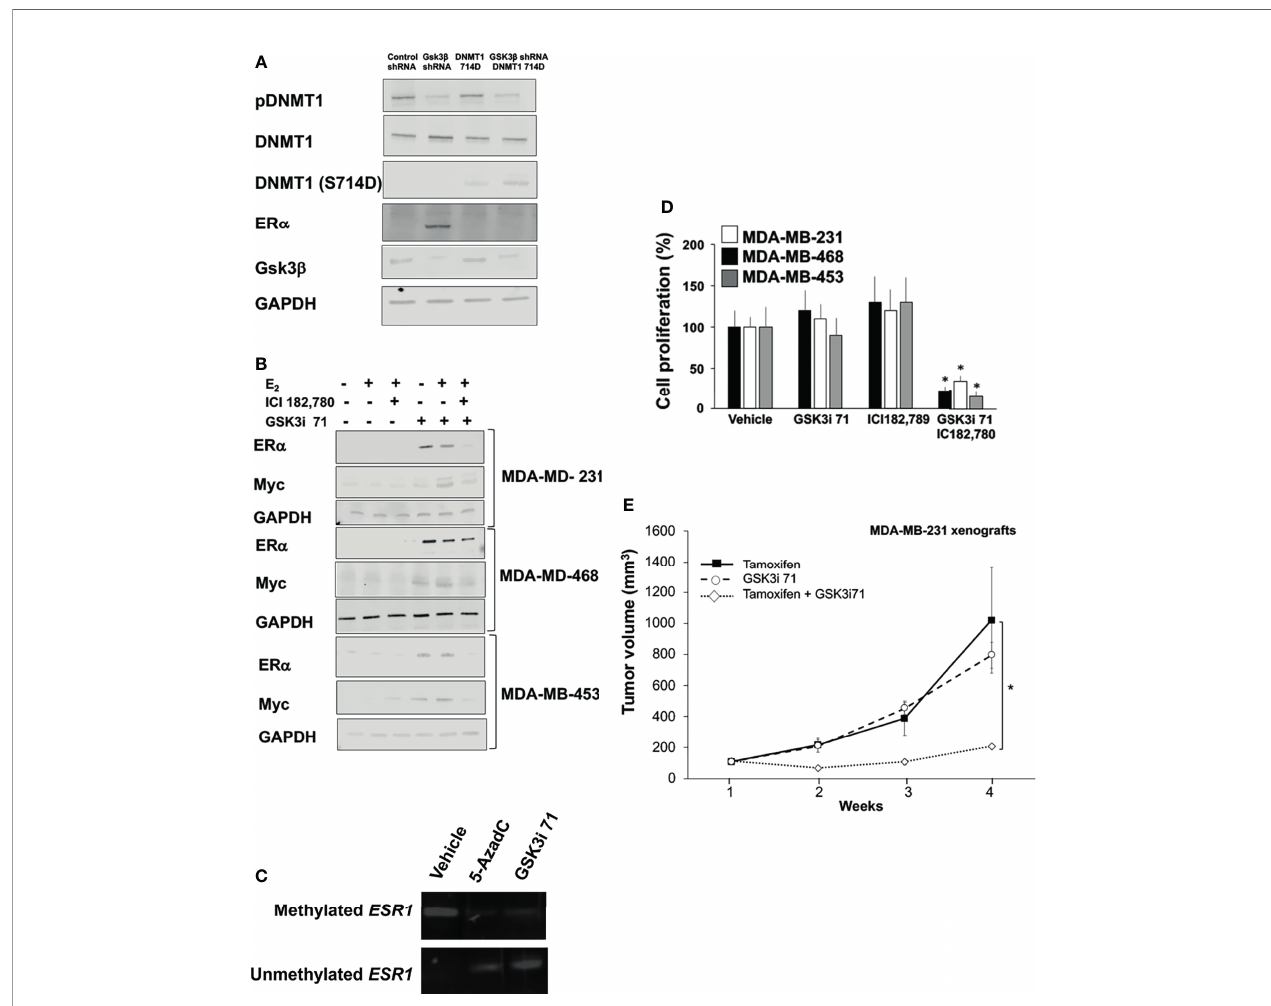
FIGURE 6 | GSK3 inhibition resulted in re-expression of ER and hormone dependence of TNBC lines. (A) MDA-MB-231 cells were transfected with expression vector for DNMT1 (S714D) and/or GSK3 b shRNA and processed for western blot analyses of indicated proteins normalized to GADPH. Figures are representative of at least 3 independent experiments. (B) TNBC lines were treated with 17 b -Estradiol (E 2 , 10 nM, 8 h), ICI182,780 (1 µM, 8 h), and/or GSK3i 71 (500 nM, 72 h). Cell were processed for western blot analyses of indicated proteins normalized to GAPDH. Figures are representative of at least 3 independent experiments. (C) MDA-MB-231 cells were treated with vehicle, 5-AzadC (5 µM), or GSK3i 71 (500 nM) for 72 h Cells were harvested and genomic DNA extracted, followed by methylation-speci fi c PCR at the promoter region of the ESR1 gene using bisul fi te-treated DNA. Figures are representative of at least 3 independent experiments. (D) TNBC lines were treated with ICI182,780 (1 µM), and/or GSK3i 71 (500 nM). After 5 days, WST-1 solution (10 mg/ml) was added to each well. The formazan crystals formed inside the viable cells were measured at 450 nm using a microplate reader. Figures are representative of at least 3 independent experiments *P<0.01 vs . vehicle treated cells. (E) Female NSG mice were implanted with MDA-MB-231 cells and treated with tamoxifen (75 mg/Kg), GSK3i 71 (10 mg/Kg), or a combination of both were administered by intraperitoneal injection daily for 4 weeks (5-6 mice/treatment group). *p < 0.01 relative to tamoxifen-treated mice based on pairwise Student